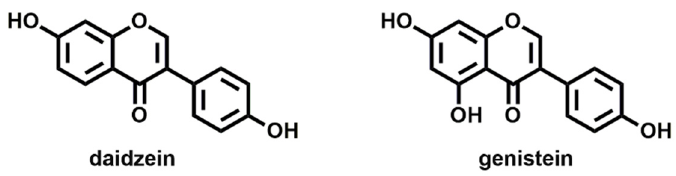
Figure 1. Molecular structures of the most common natural phytoestrogens: daidzein and genistein. Synthetic EDCs are far more diverse, with several hundred identified and classified as persistent (exhibiting bioaccumulation) or non-persistent in the environment. These compounds are present in many commonly used household and industrial products.